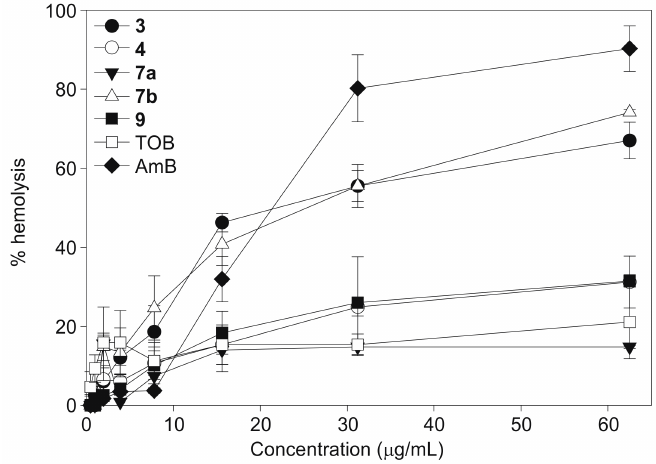
Figure 1. The hemolytic activity of tobramycin (TOB); its derivatives 3 , 4 , 7a , 7b , and 9 ; as well as AmB on mRBCs. Note: the exact values used to generate this graph are presented in Table